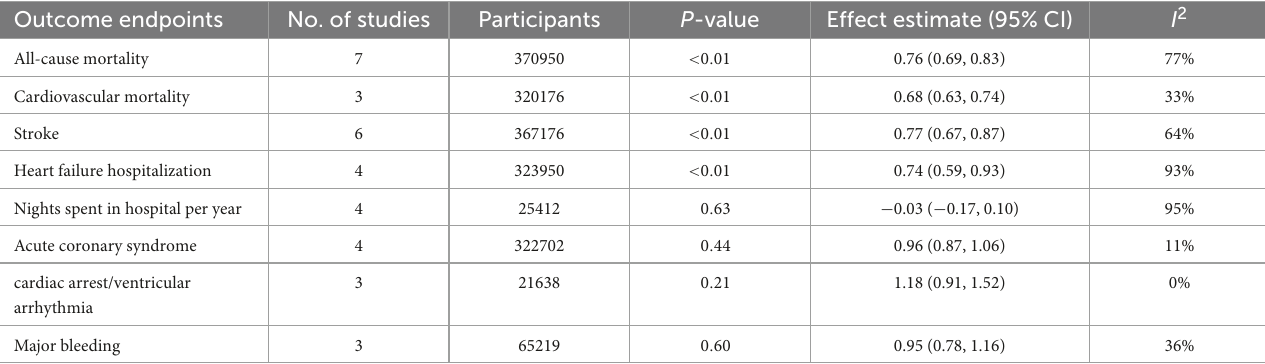
TABLE 3 Outcome of patients who underwent early rhythm control or rate control for atrial